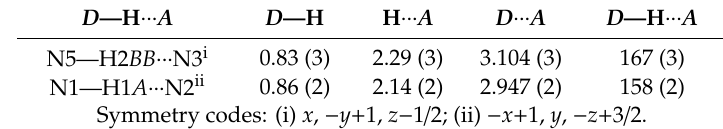
Table 2. Hydrogen-bond geometry (Å).